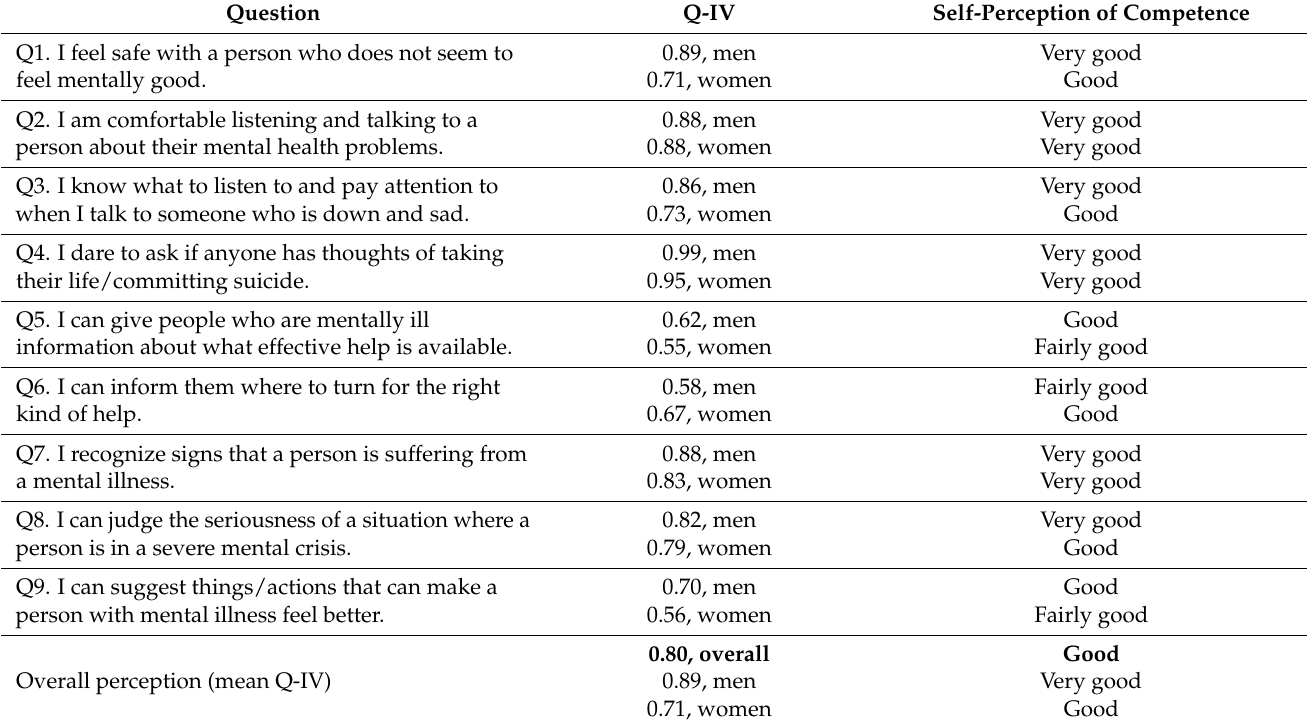
Table 3. Question index values (Q-IV), indicating self-perceived competence